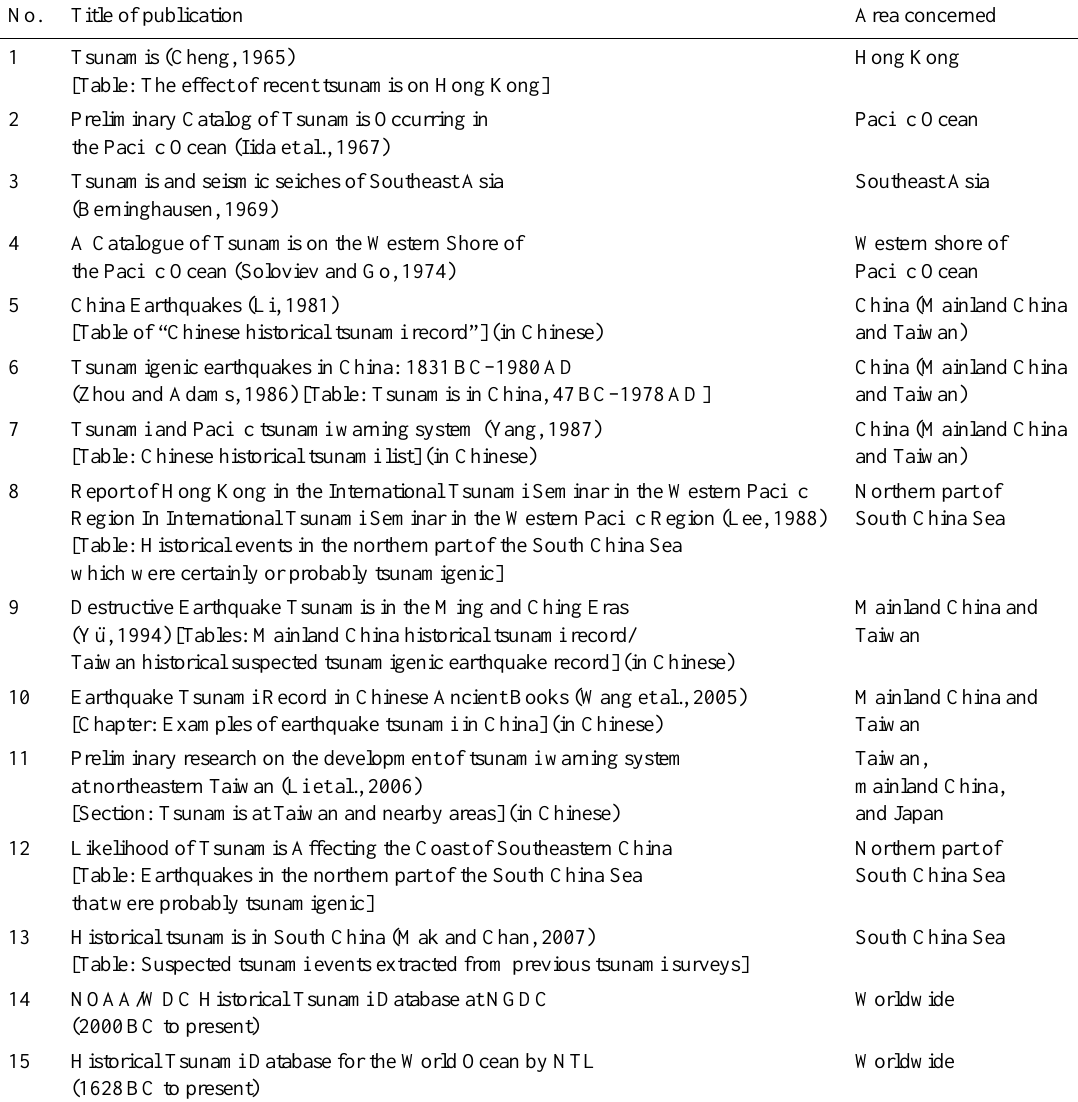
Table 2. List of source catalogues and publications containing tsunami data of the region used in this study. No. [Table: The effect of recent tsunamis on Hong Kong]